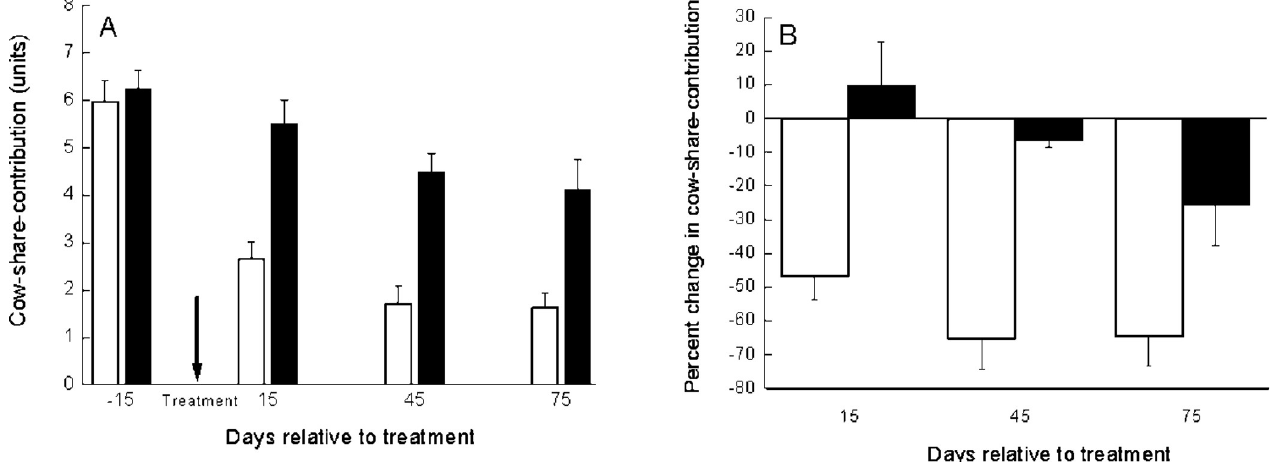
Fig 3. Cow-share-contribution of somatic cells to the bulk milk tank. Mean and SE of cow-share-contribution of somatic cells to the bulk milk tank ( 3A ; arrow indicates time of treatment) and changes in individual cow-share-contribution ( 3B ) relative to time of treatment (t = 0) during the first 75 d post- treatment of 103APT ( □ ) and 103 untreated ( ■ ) cows with mastitis.